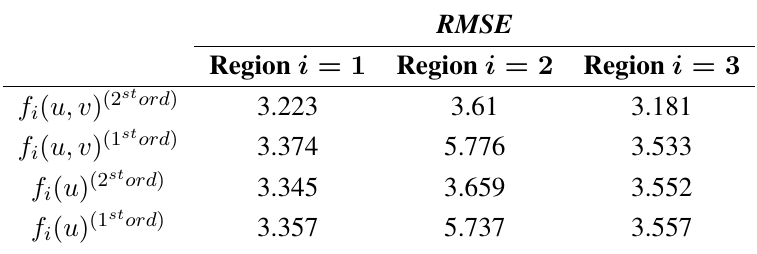
RMSE obtained by the application of the four models used for the modified